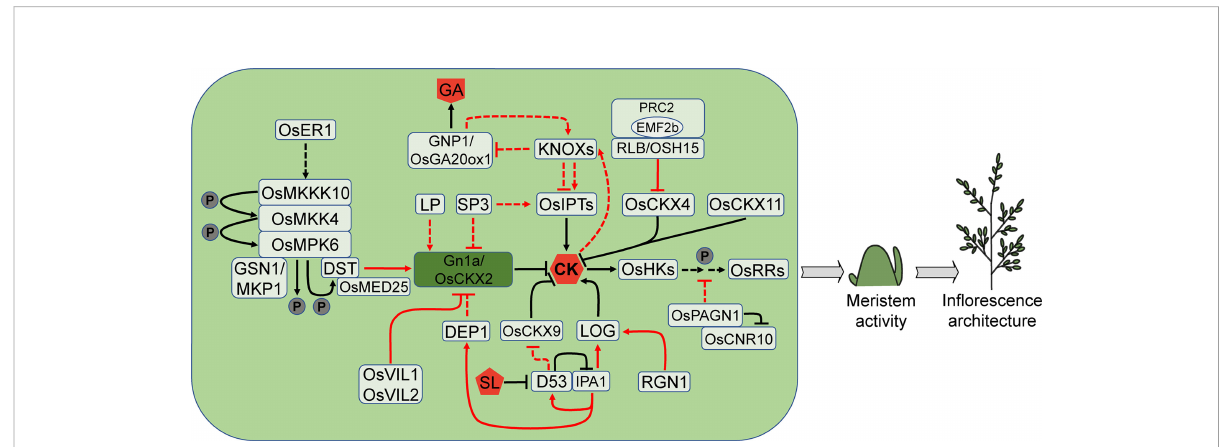
and yield, is controlled by numerous other factors. CK also collaborates with other hormones such as GA and SL, in controlling rice in fl orescence architecture. Arrows and blocked arrows represent positive and negative regulation, respectively. Solid and dashed lines represent direct and indirect regulation, respectively. Red and black lines represent regulation between factors at transcriptional and protein level, respectively. P, phosphorylation; CK, cytokinin; GA, gibberellin; SL,